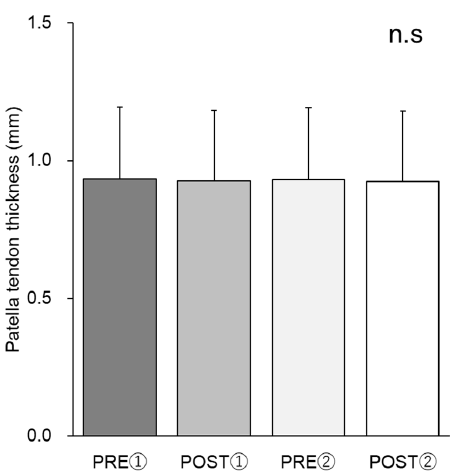
Figure 5. Blood flow area.